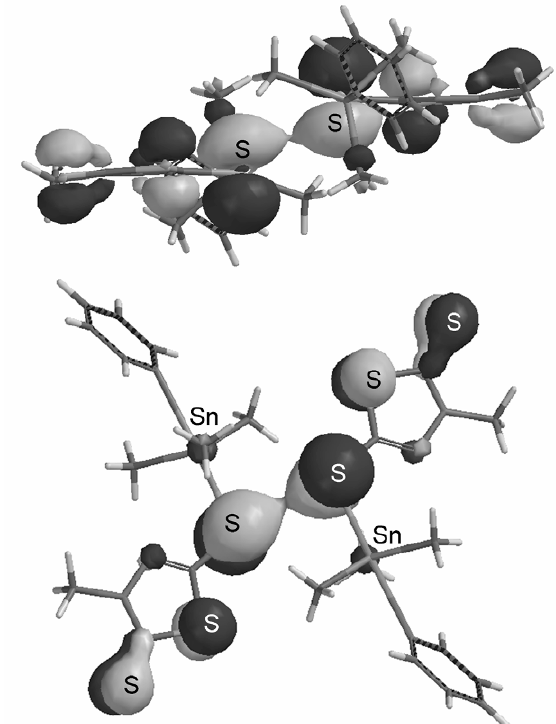
Figure 3. Two views (perpendicular to each other) of the HOMO-5 orbital of the system shown in Fig. 2 (BP86/6-31G**, single-point calculation on crystal structure coordinates).